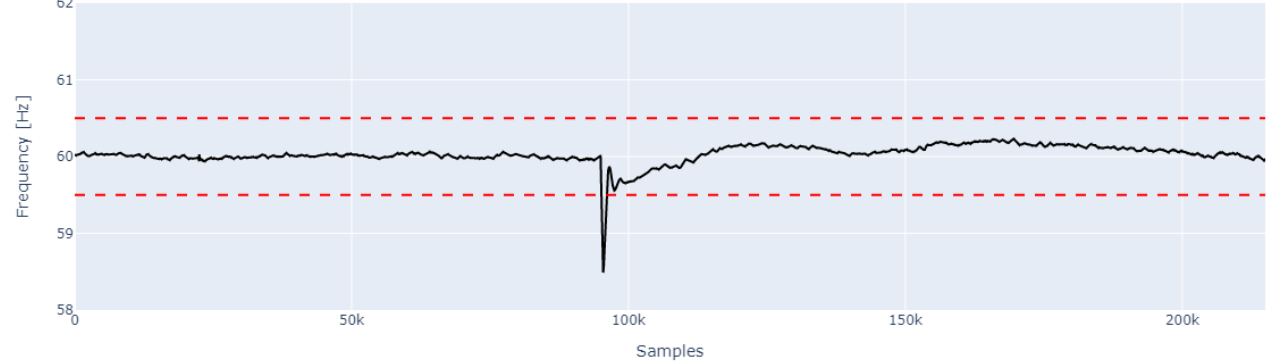
Figure 7. Event 1: frequency of PMU Bateias (in the east of Parana State).